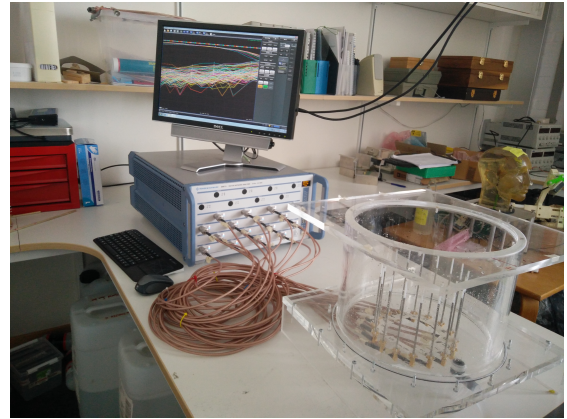
Figure 1. The measurement system used for the study. To the left is the VNA and to the right is the immersion tank containing the antennas and the coupling